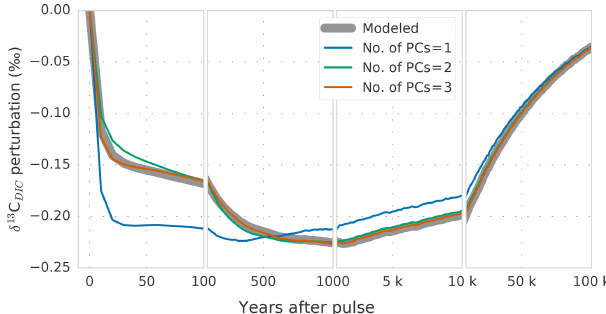
Figure 5. Modeled global-average perturbation of the isotopic sig- nature of dissolved inorganic carbon in the ocean ( δ 13 C DIC ; thick gray line) in response to a carbon pulse to the atmosphere of 500GtC with a δ 13 C signature of − 24‰. The thin colored lines show the perturbation as reconstructed with one (blue), two (green), and three (orange) principal